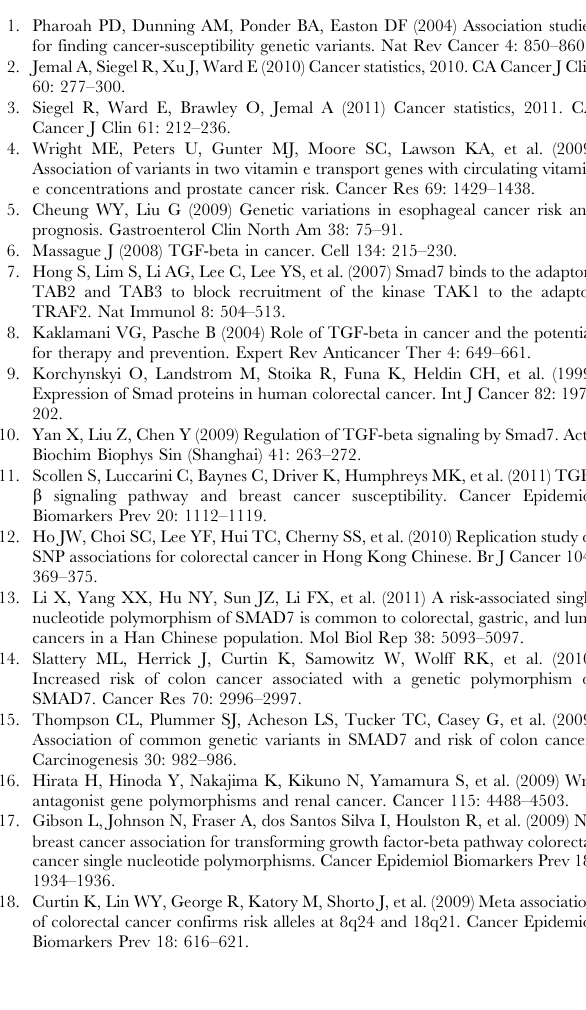
Figure S6 Forest plot of ORs with 95% CI for SMAD7 rs12953717 polymorphism and overall cancer risk (T versus C). (PNG) Table S1 ORs (95% CI) of sensitivity analysis for SMAD7